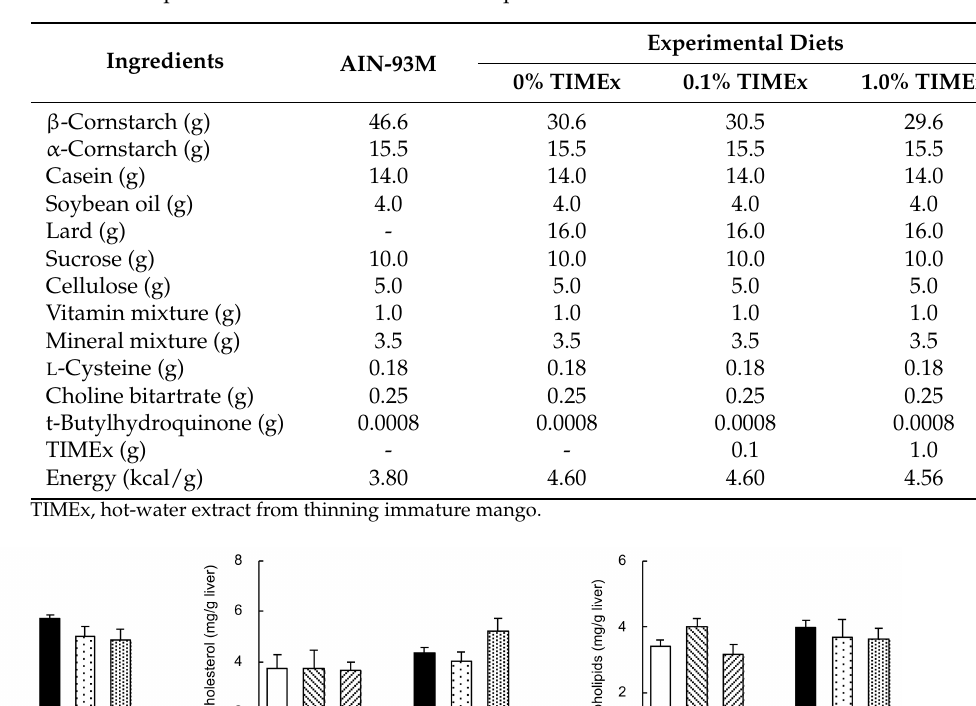
Table 2. Composition of the AIN-93M–based experimental diets.